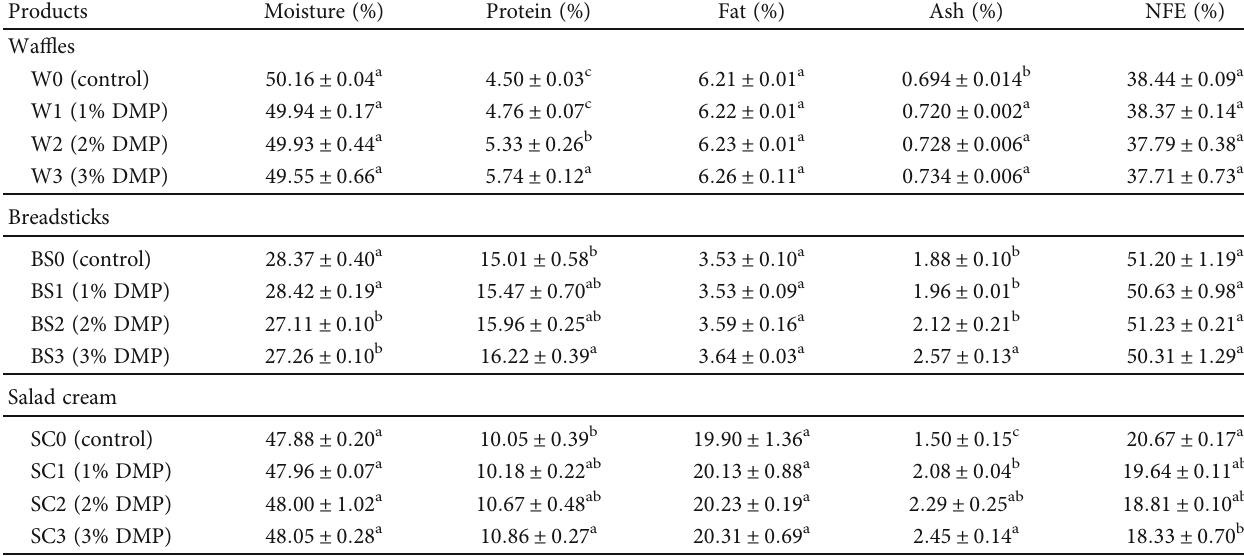
DMP: Oyster mushroom powder. Results are reported as mean ± SD of triplicate analysis. Means with the same letters are not signi fi cantly di ff erent ( P < 0 : 05 ) in the same